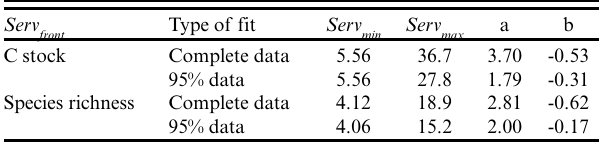
Table 2 . Parameter estimates for the fit of the logistic function to model the site-level efficiency